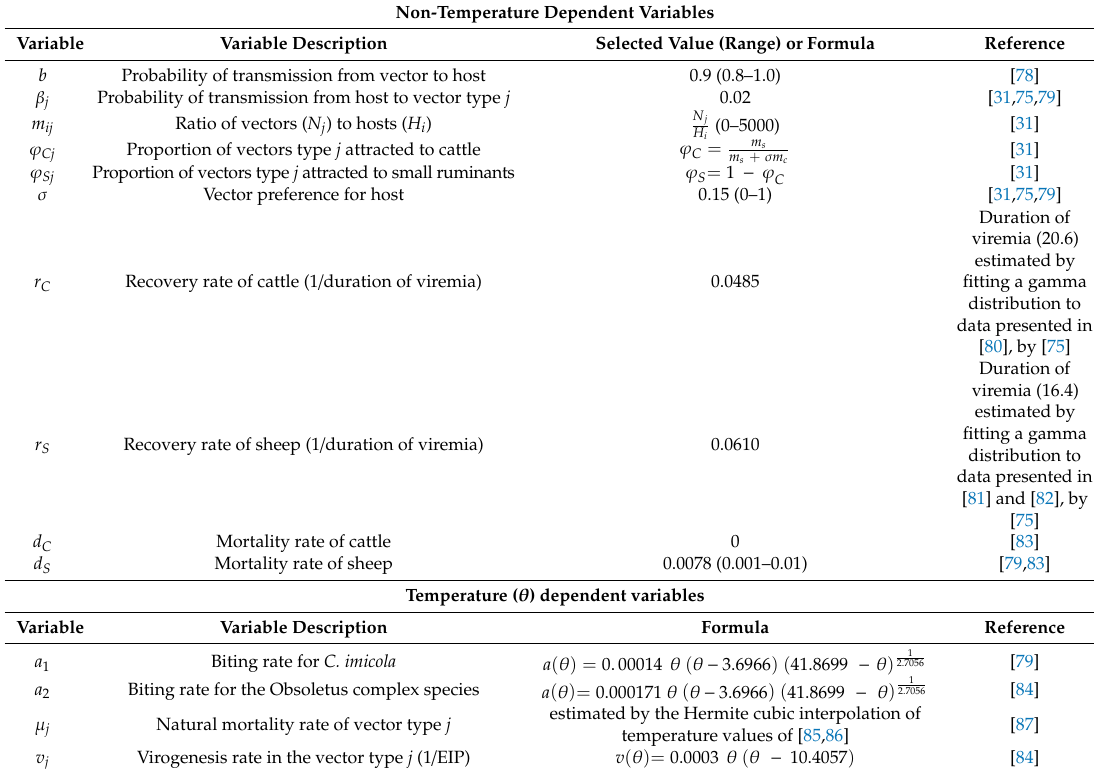
Table 1. Parameters for R 0